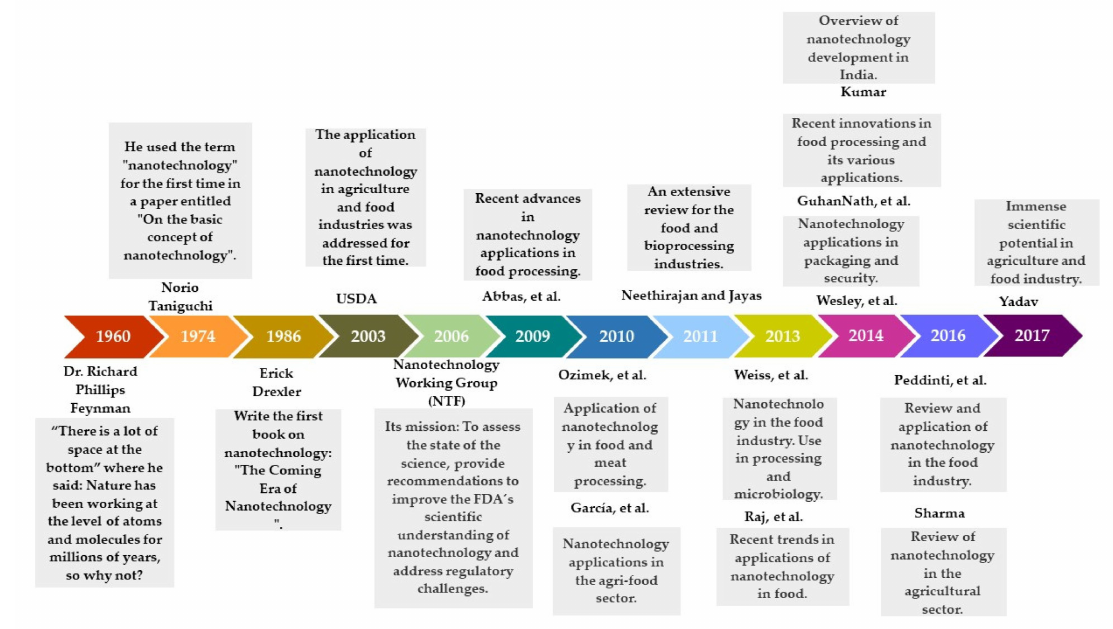
Figure 1. Chronology of nanotechnology applied to